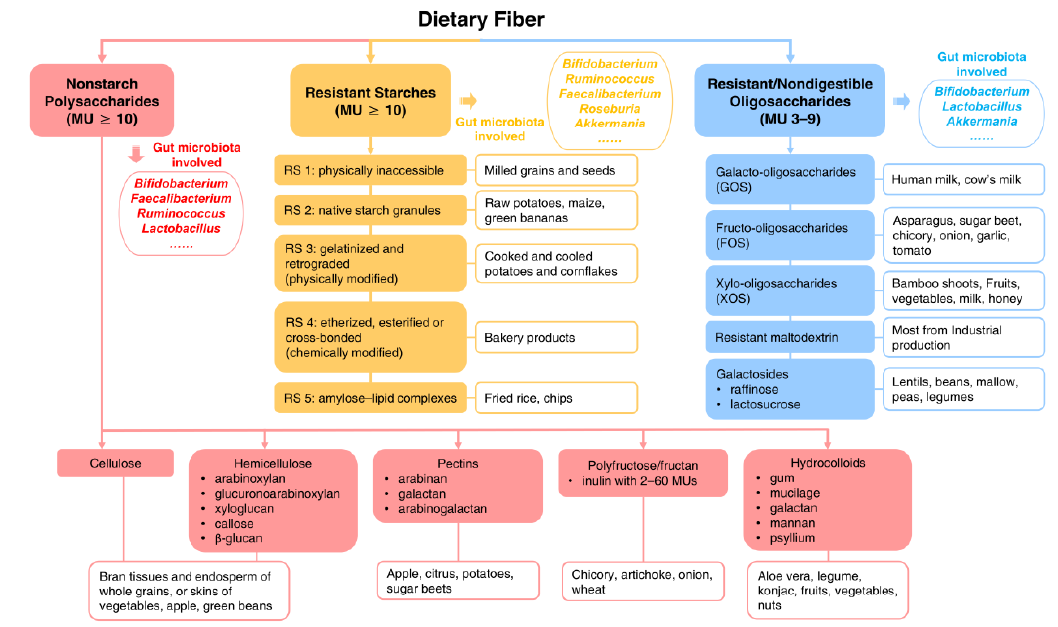
Figure 1. Type of dietary fiber. MU: monomeric unit.